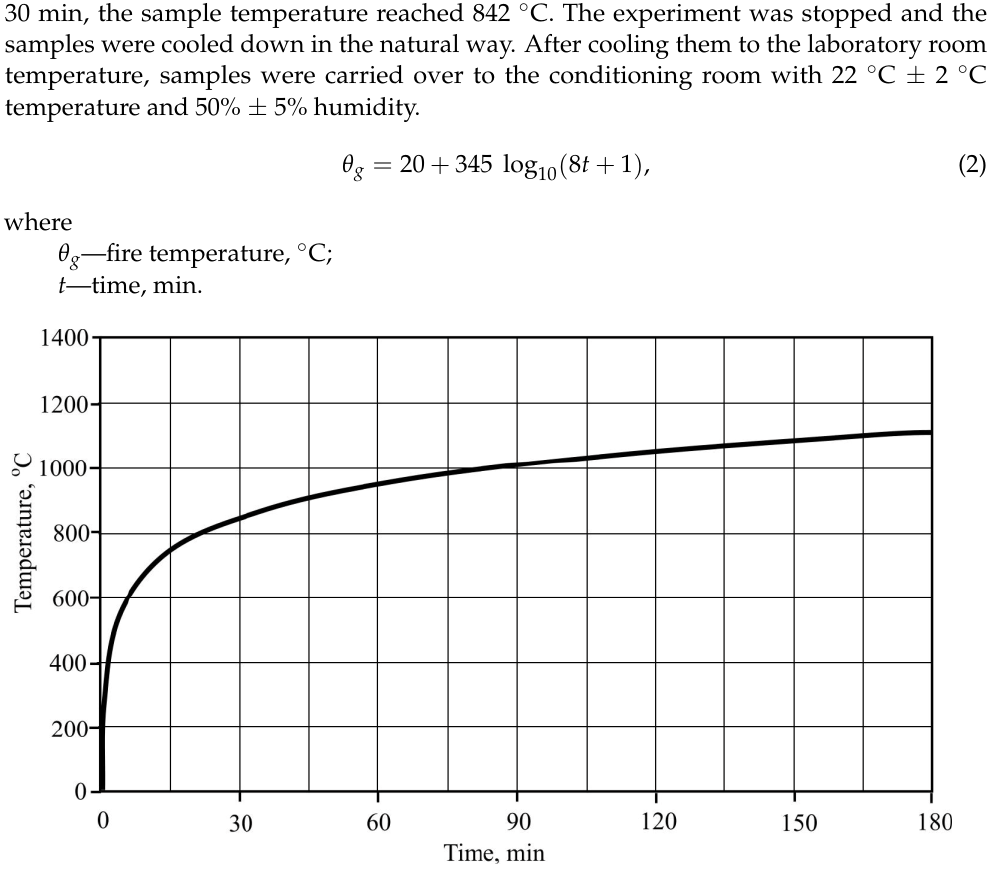
Figure 3. Standard fire